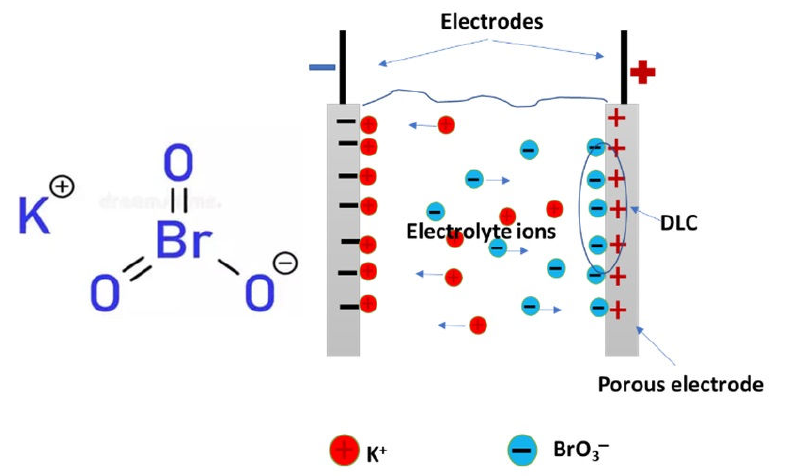
Figure 12. Electrochemical reactions mechanism occurs at the electrolyte and electrode